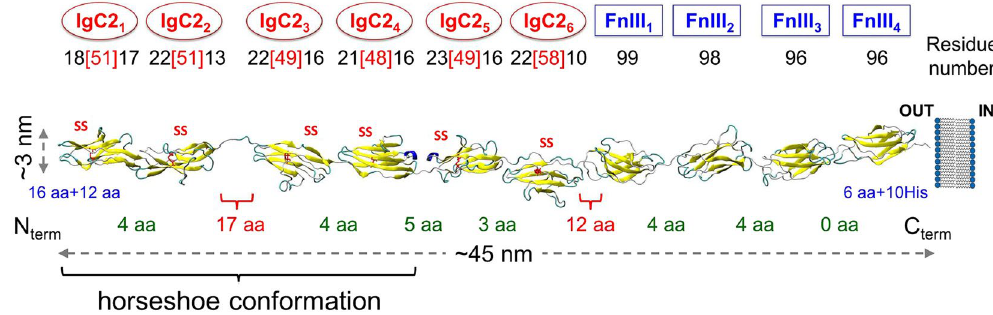
Figure 1. Modular structure of CNTN4. The protein consists of six N-terminal IgC2 domains and four fibronectin type III (FnIII) domains. Each IgC2 domain is restrained by one disulfide bond (SS) that protects half of the domain (marked by red licorice). The numbers of residues that form each domain have been described in the following way: total number of residues for FnIII modules and split into three parts for IgC2 modules i.e. the number of residues harbored by disulfide bridge (in the square bracket) surrounded by the number of residues before and after disulfide bridge. The length of the protein is ~45 nm, when the domains are aligned. The number of free amino acids (aa) linking each pair of consecutive modules is shown. The first four IgC2 domains preferentially assume a horseshoe